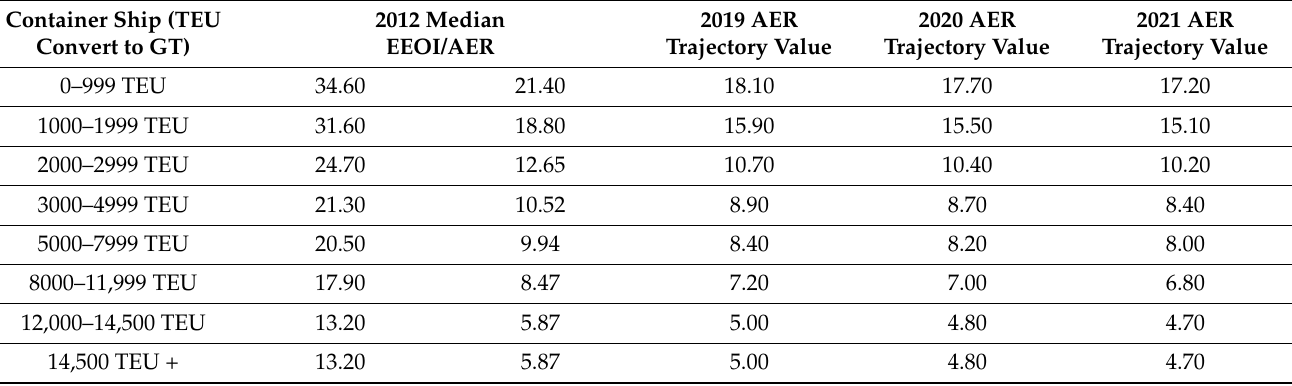
Table 1. The Decarbonization Trajectory of the Poseidon Principle.